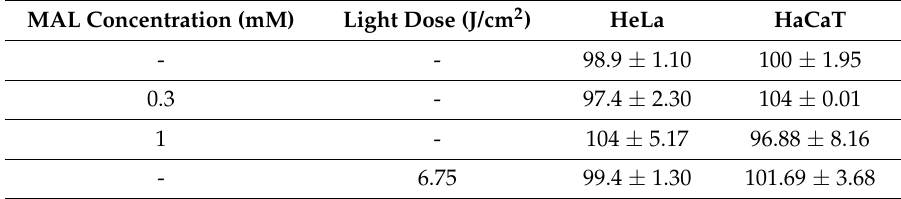
Figure 1. Phototoxicity induced by MAL-PDT (photodynamic therapy with methyl-aminolevulinate) in HaCaT (non-tumorigenic human keratinocytes cell line) and HeLa (cervical human carcinoma) cells. Cells were incubated with 0.3 or 1 mM of MAL for 5 h and then irradiated with red light at variable doses. In HeLa cells, the response to MAL-PDT was dependent of the concentration of MAL and the light dose. HaCaT were not sensitive to these conditions of PDT. The photoeffects were evaluated by the MTT test 24 h after treatments. Each value corresponds to the mean obtained from three independent experiments ± SD. (* p < 0.05; *** p < 0.001). Table 1. Toxicity induced in HeLa and HaCaT cells by MAL or red light alone. Cells were incubated for 5 h with MAL at different concentrations or irradiated with the highest light dose used in the phototoxicity experiments. Toxicity was evaluated by the MTT test 24 h after treatments. Each value corresponds to the mean obtained from three independent experiments ± SD.